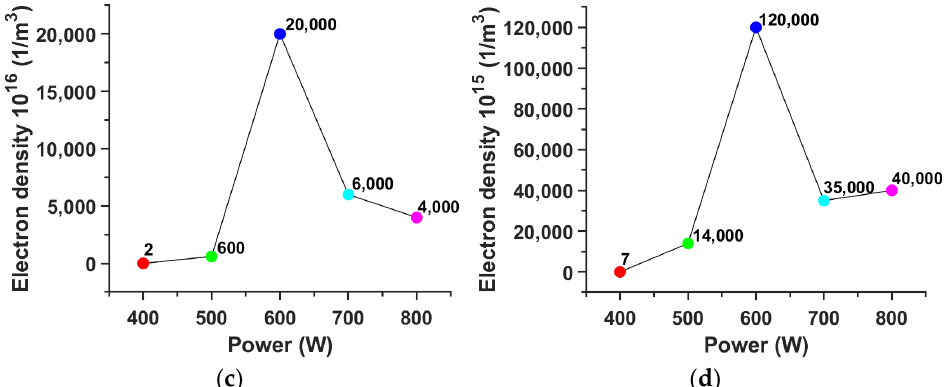
Figure 7. Electron density of the argon plasma as a function of microwave power level for gas pressures of ( a ) 5 Torr, ( b ) 35 Torr, ( c ) 70 Torr, and ( d ) 90 Torr.